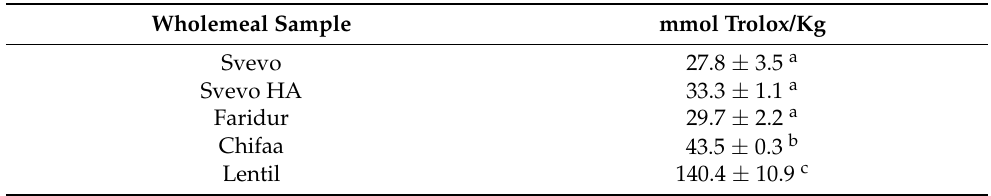
Table 4. Antioxidant capacity of Svevo, Svevo-HA, Faridur, Chifaa and lentil wholemeal flours. a–c Different letters show significant differences ( p < 0.05).